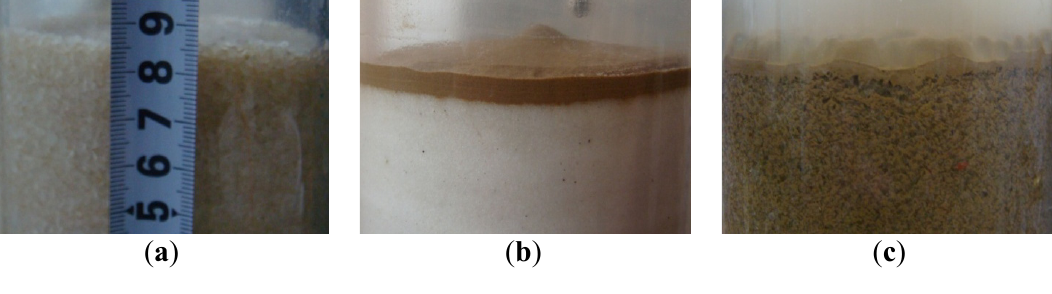
Figure 3. Pictures of different types of suspended solids clogging. ( a ) Surface